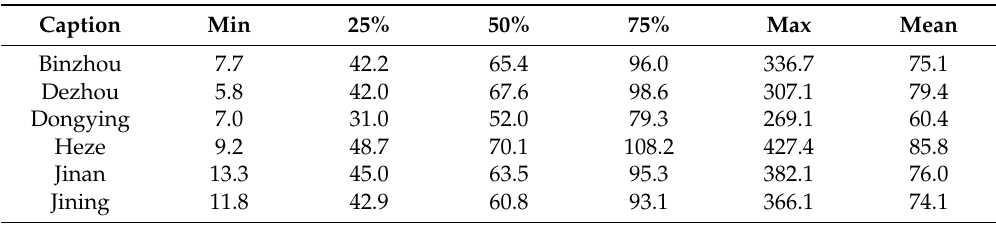
Table A1. Descriptive statistics of the daily mean PM 2.5 levels ( µ g/m 3 ) in the 17 cities of the